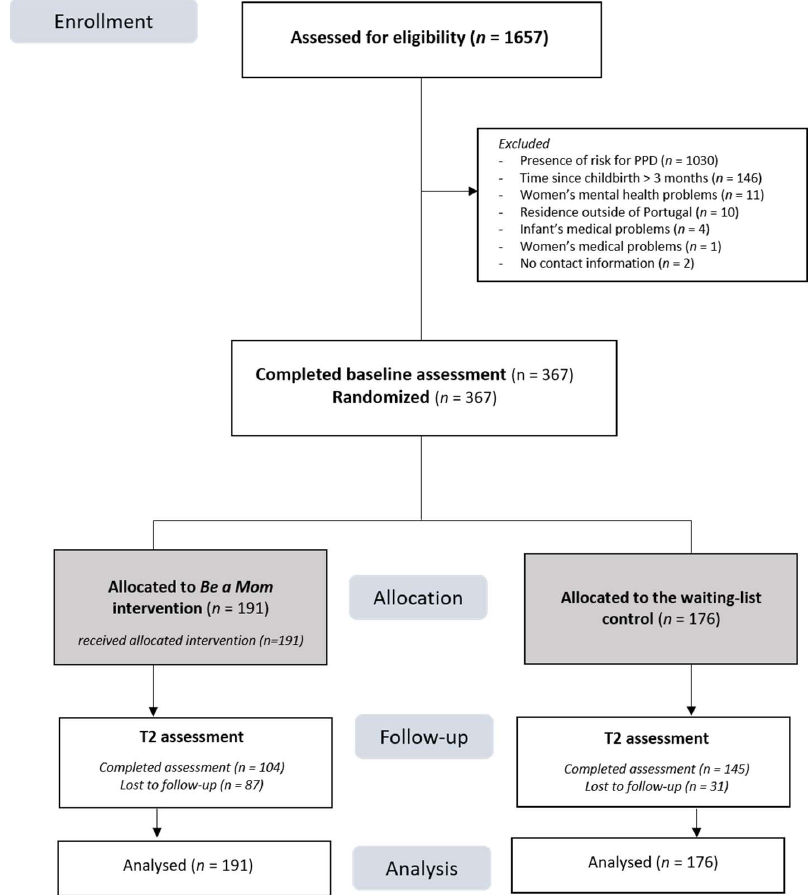
Figure 1. Flowchart of the participants in the study .